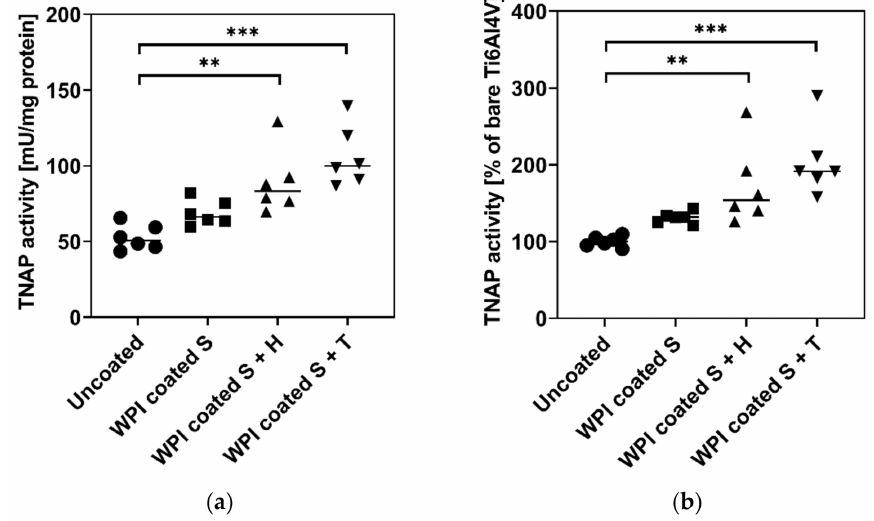
Figure 6. TNAP activity of hBMSC on bare and coated Ti6Al4V. 6500 hBMSC/sample plated in onto bare Ti6Al4V and Ti6Al4V coated WPI, WPI + heparin, and WPI + tinzaparin. From day four after plating, the cells were cultured with osteogenic supplements and analysed at day 11 for TNAP enzyme activity. The results are shown as mean (bar) and individual values; n = 3. Statistical significant differences versus bare Ti6Al4V are indicated with ** ( p < 0.01) and *** ( p < 0.001). ( a ) mU/mg protein; ( b ) % of bare